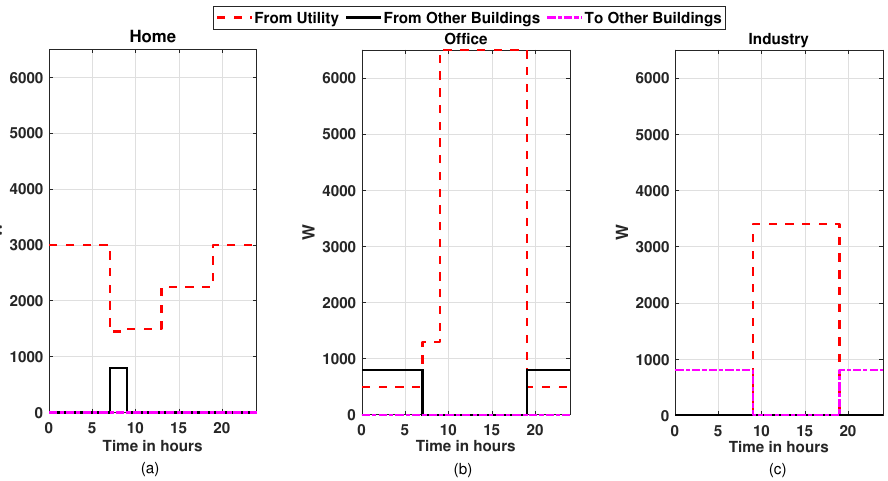
Figure 13. Cooling cooperation among the buildings for 24 h in the month of June, ( a ) for the home building, ( b ) for office building, and ( c ) for industry